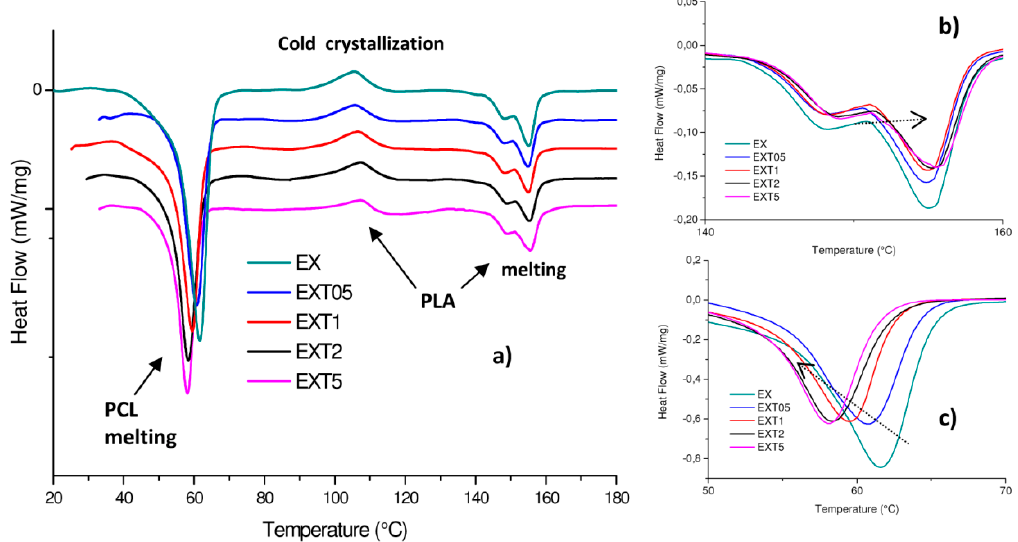
Figure 3. The analysis of blended materials ( a ); magnification of the PLA ( b ) and PCL ( c ) melting range. Table 2. The DSC data of all the extruded threads.